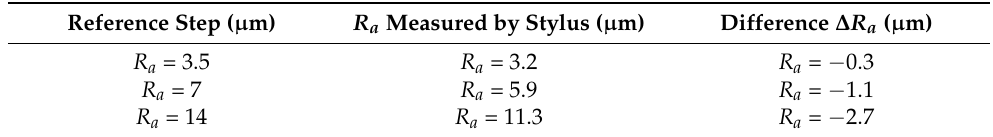
Figure 15. Simulation of a roughness measurement performed with a stylus’ three step functions of increasing amplitude. In the top left corner, there are the dimensions of the stylus tip: the tip radius is 2 µm and the tip angle is 60°. Table 3. Surface roughness of step function. Table 3. Surface roughness of step